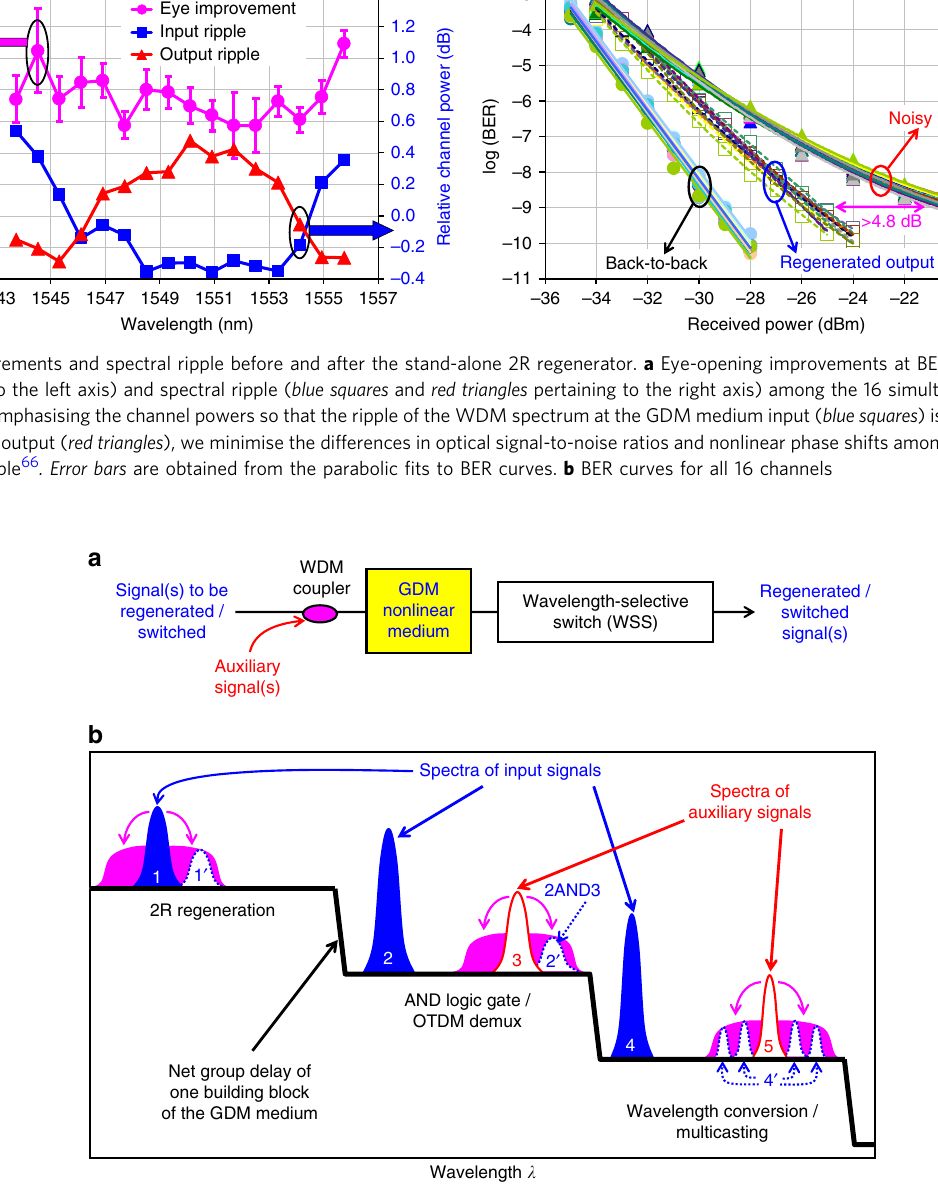
Fig. 8 Schematics of different GDM-enabled all-optical processing applications. These different applications could be potentially implemented simultaneously and independently for signals at multiple wavelengths. a Multi-channel signals, combined with auxiliary beams, enter the GDM medium, after which the appropriate output beams are selected by a WSS. b Top step of the ʽ staircase ʼ in the group-delay spectra ( black ): Mamyshev 2R regenerator implemented for channel 1. Middle step: XPM-based AND operation (or OTDM demultiplexing) between channel 2 and auxiliary signal 3. Bottom step: wavelength conversion/multicasting of channel 4 by its XPM of auxiliary signal 5. Beams 1 ′ , 2 ′ and 4 ′ ( dotted blue ) are selected by the WSS at the output, and the rest of the signals are discarded. Note that the GDM medium permits independent processing of multiple channels for as long as different signal channels ( solid blue ), along with their respective auxiliary beams ( red ), occupy different stairsteps of the group-delay staircase